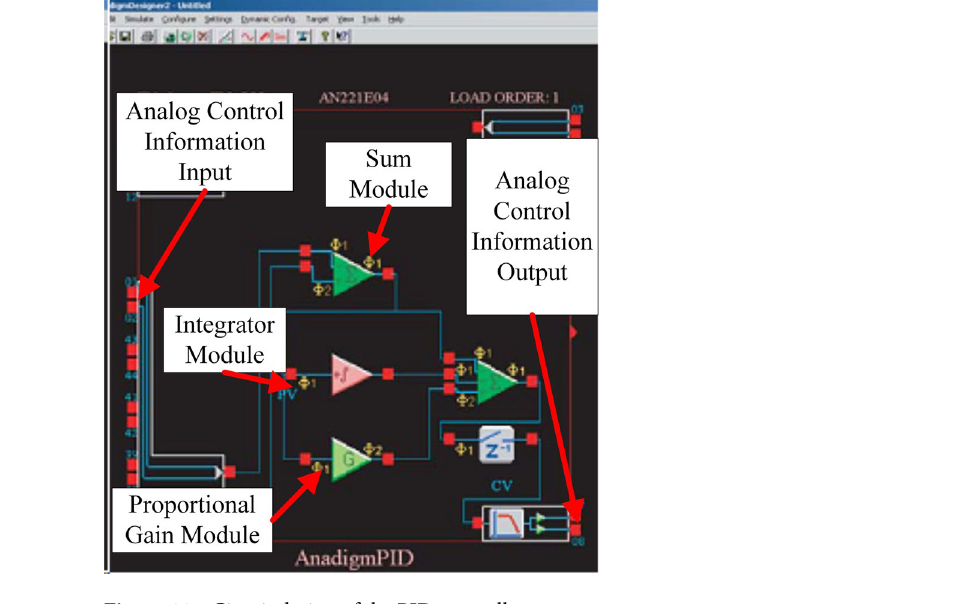
Figure 11. Circuit design of the PID controller.